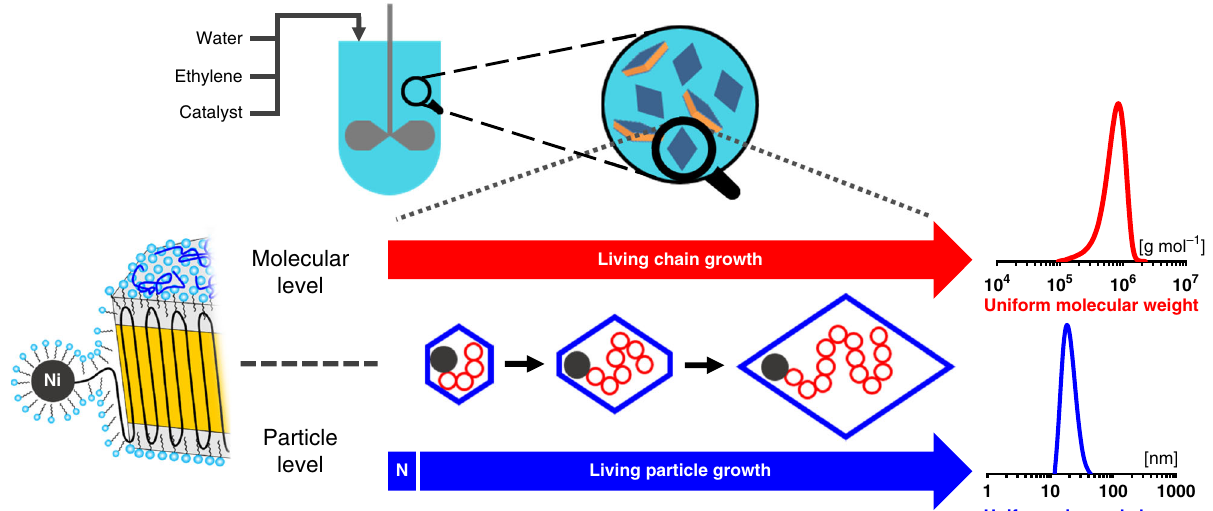
Fig. 1 Concept to obtain uniform size and shape particles by controlled polymerization on a molecular as well as particle level. An effective nucleation (N) ensures that particles contain only one active site, and start to grow virtually at the same time. Due to the living character of polymerization, all particles continue to grow for the entire duration of the experiment, to yield particles each composed of a chain of identical length. As the growing chains are immediately deposited on the growing single-crystal particle during this process, particle shape evolves uniformly over time during polymerization